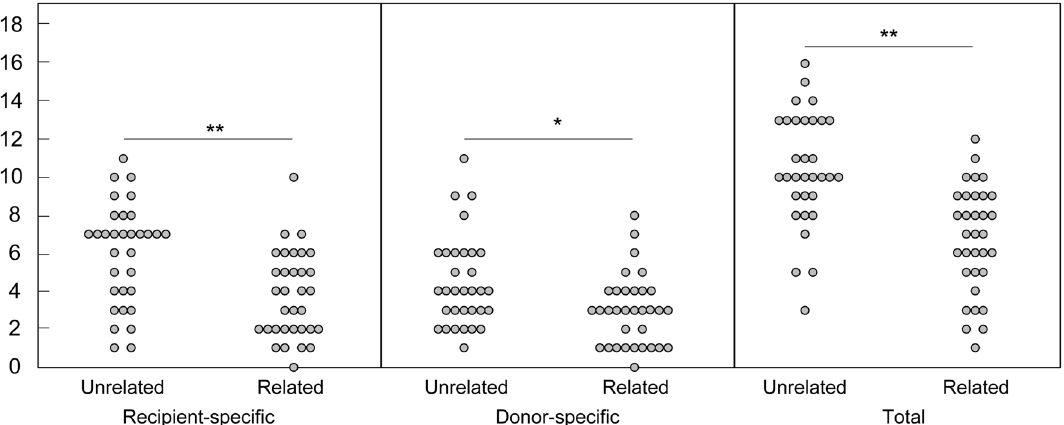
Figure 2. Numbers of recipient-specific, donor-specific, and total informative markers in KMRtype Core kit for each donor/recipient pair. *: p < 0.05, **: p < 0.01.